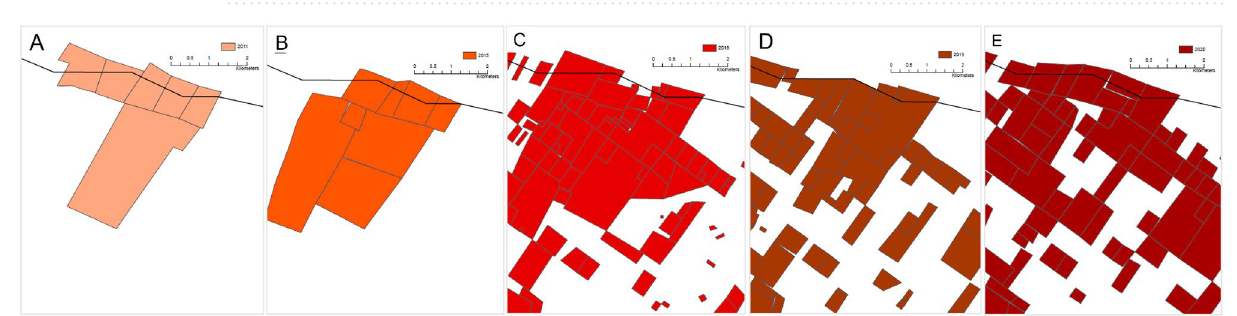
Figure 6. The expansion of fencing around a plot of land in Maji Moto, the Greater Mara, Kenya. ( A ) 2011, ( B ) 2015, ( C ) 2018, ( D ) 2019, and ( E ) 2020. Each section is 5.5 × 5.5 km on the ground. Based on ArcMap (vs.